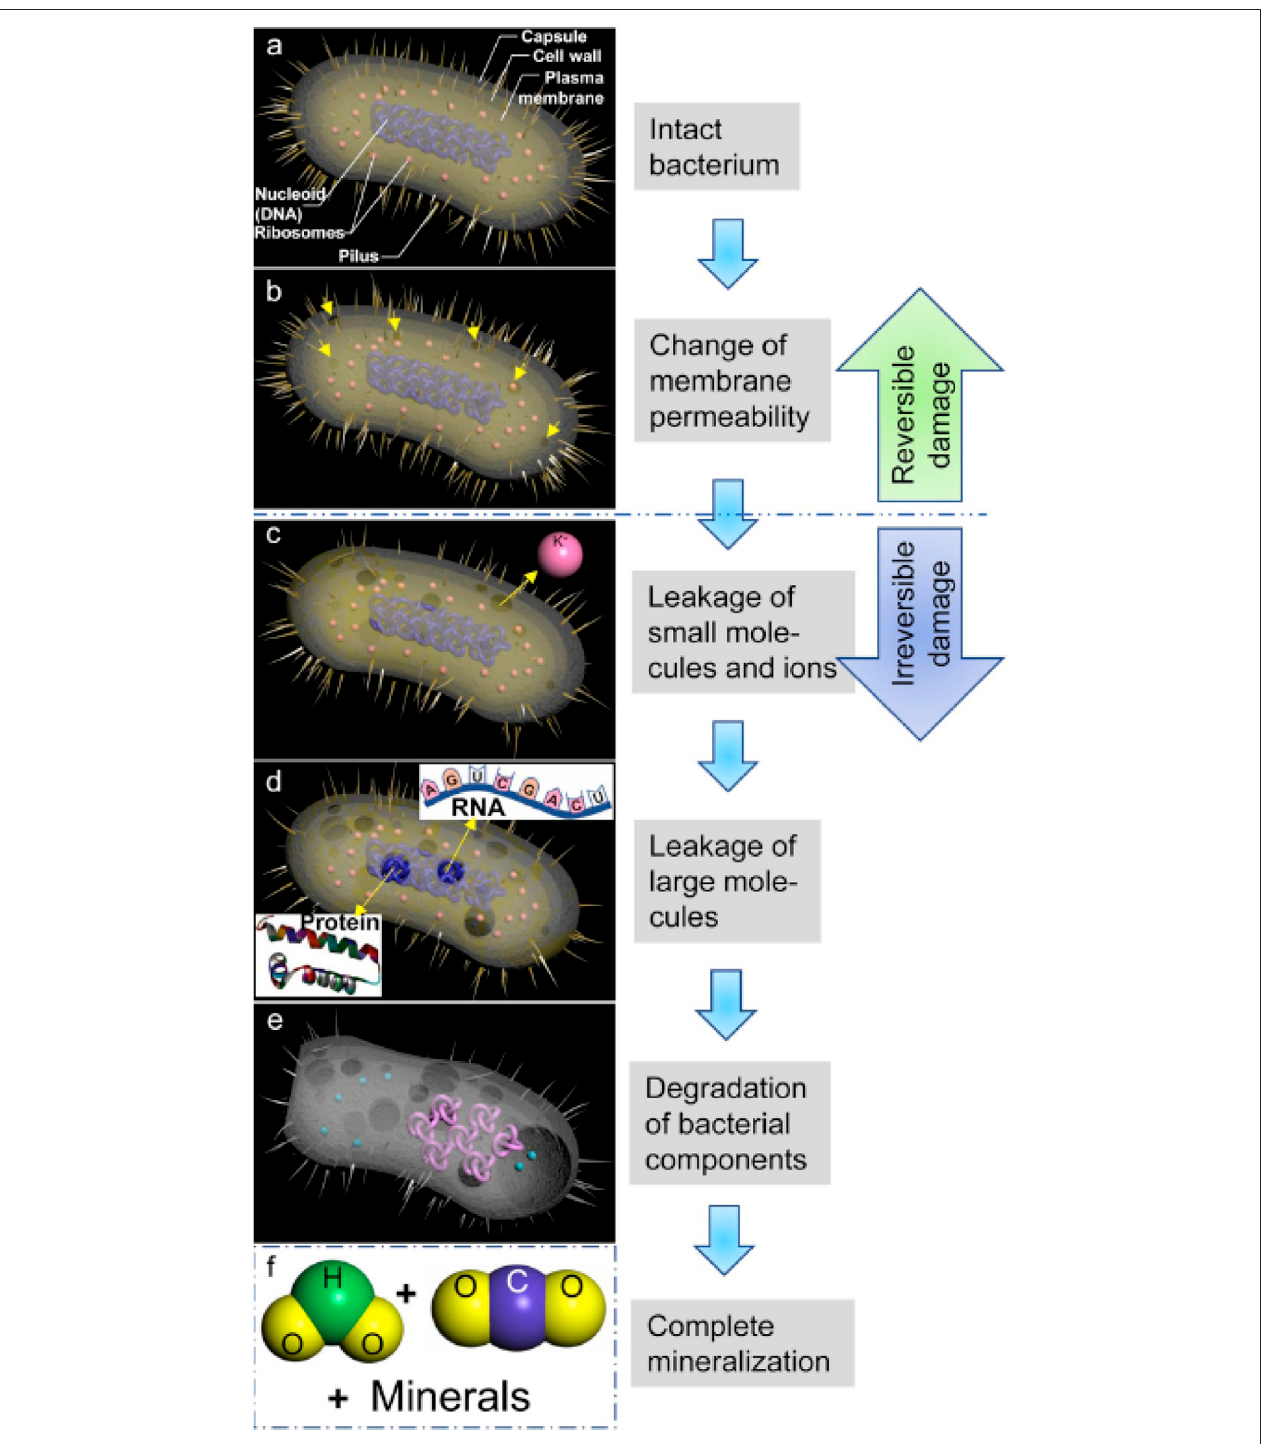
FIGURE 7 | Photocatalytic bactericidal process of TiO 2 photocatalysts. Adapted from Ge et al. (2019). Copyright © 2020 Production and hosting by Elsevier B.V. (A) An intact bacterium; (B) Bacterial oxidized by TiO (C) The bacterium leak small molecules and ions; (D) Leakage of higher molecular weight 2 photocatalysis; components; (E) Degradation of bacterial internal components; (F) The bacterium was completely mineralized.